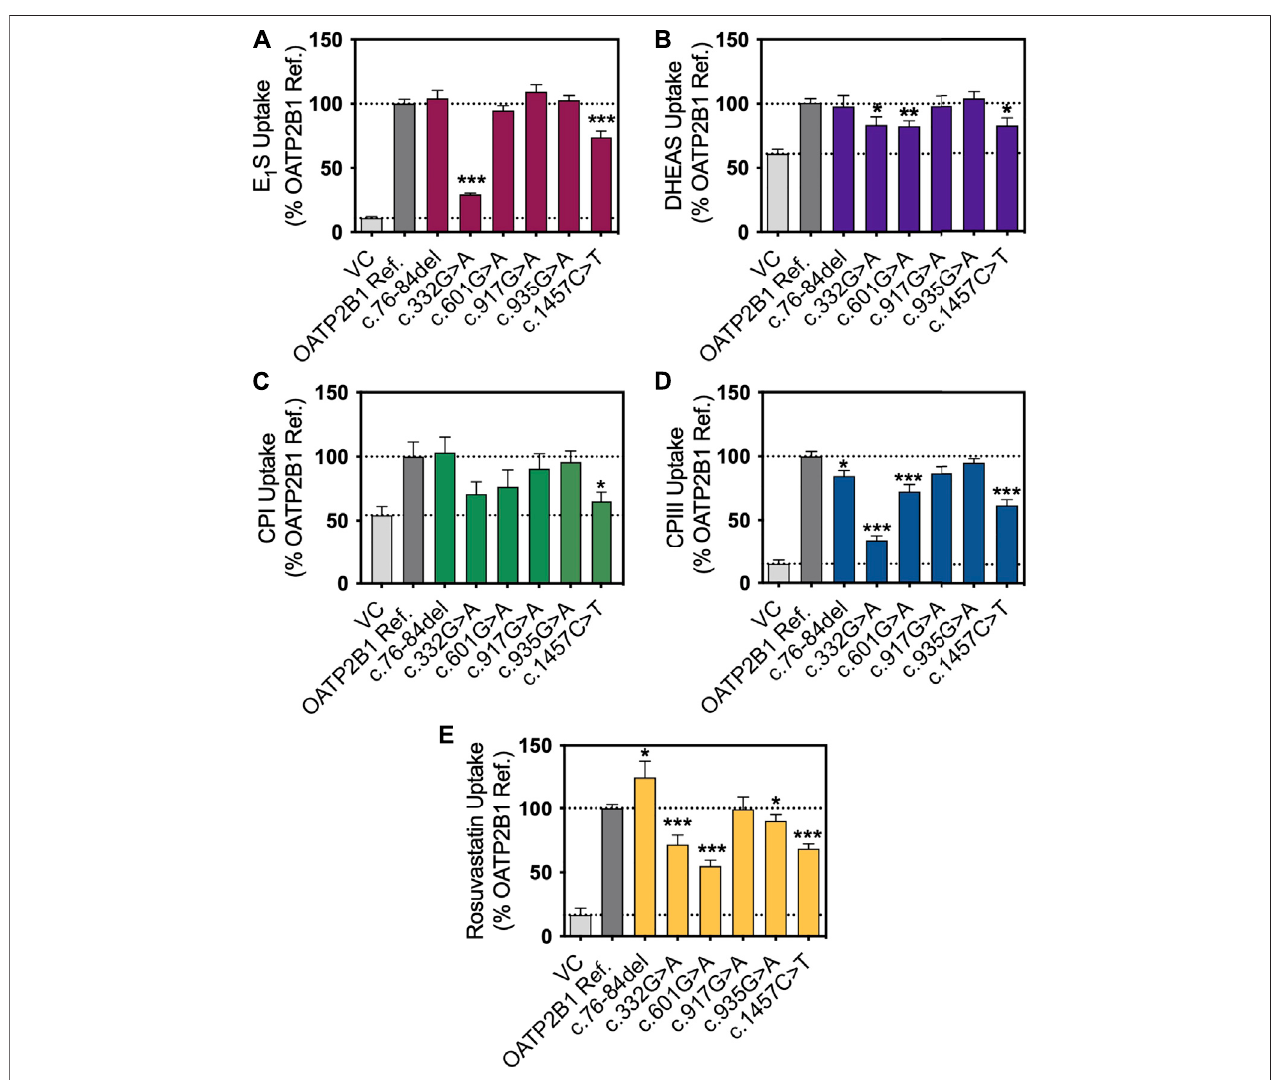
FIGURE 2 | In vitro transport activity of OATP2B1 genetic variants with substrates. Cellular accumulation of (A) estrone sulfate, (E 1 S) (1 μ g/ml, n (cid:2) 3), (B) dehydroepiandrosterone sulfate (DHEAS) (1 μ g/ml, n (cid:2) 4), (C) coproporphyrin (CP) I (1 μ g/ml, n (cid:2) 3), (D) CPIII (1 μ g/ml, n (cid:2) 3) and (E) rosuvastatin (1 μ g/ml, n (cid:2) 3) in HEK293T cells were transiently transfected with vector control (VC), OATP2B1 reference and OATP2B1 variants after incubation for 10 min (E 1 S, DHEAS, CPIII and rosuvastatin) or 30 min (CPI) in Krebs-Henseleit buffer (KHB) at pH 6. Results are shown as mean ± SEM, * p < 0.05, ** p < 0.01, *** p < 0.001.